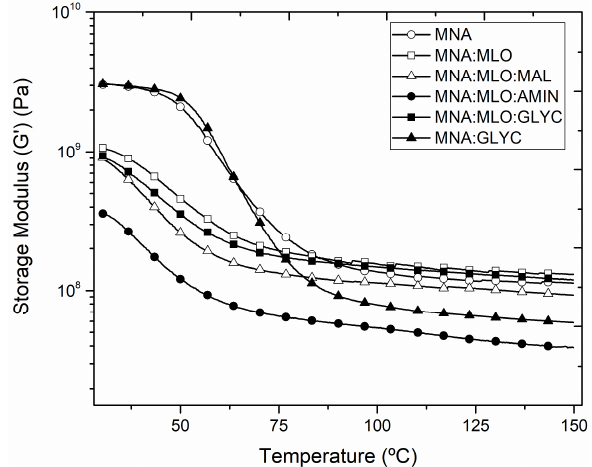
Figure 6. Comparative plot of storage modulus (G’) of different composites based on ELO epoxy resin cross-linked with MNA/MLO mixture and flax fabric reinforcement with different surface treatments.